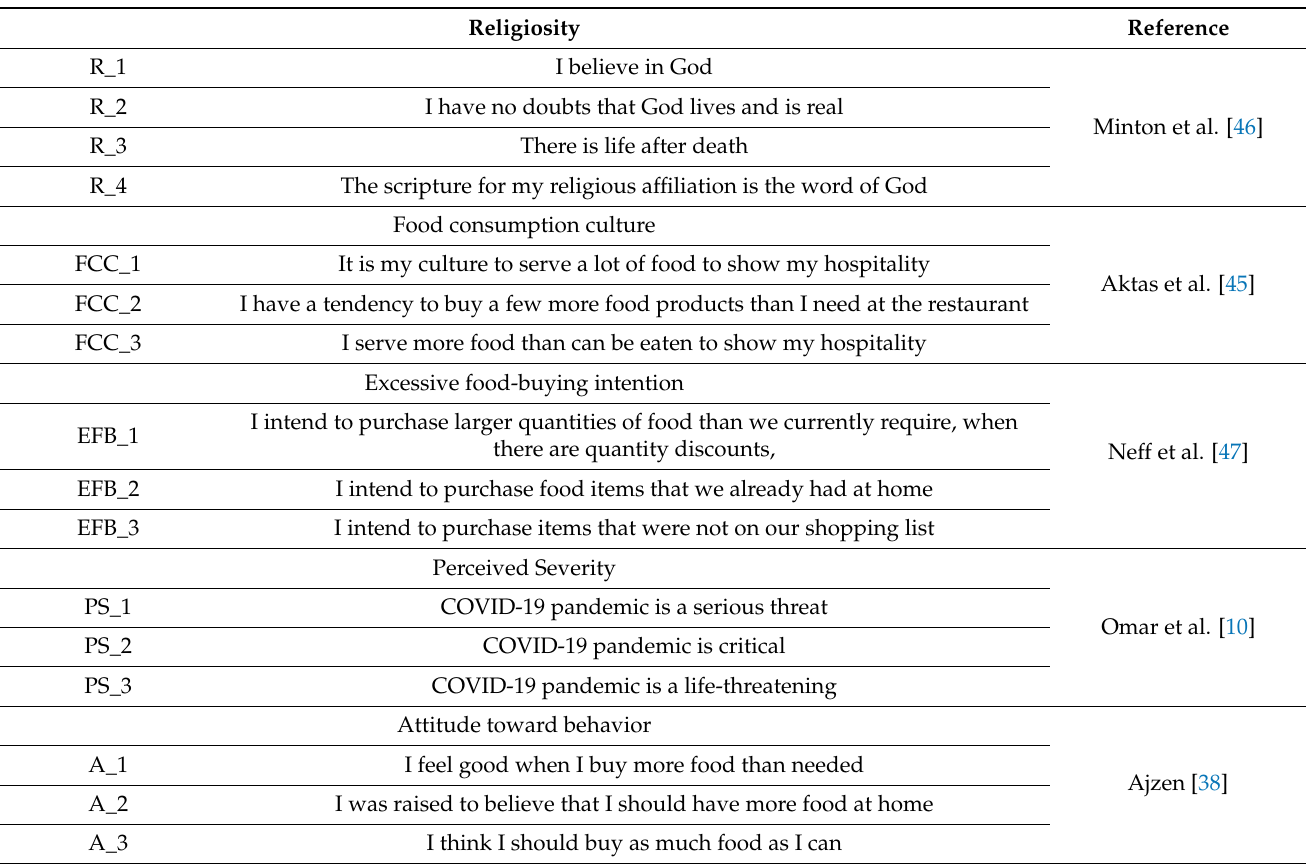
Table A1. The research